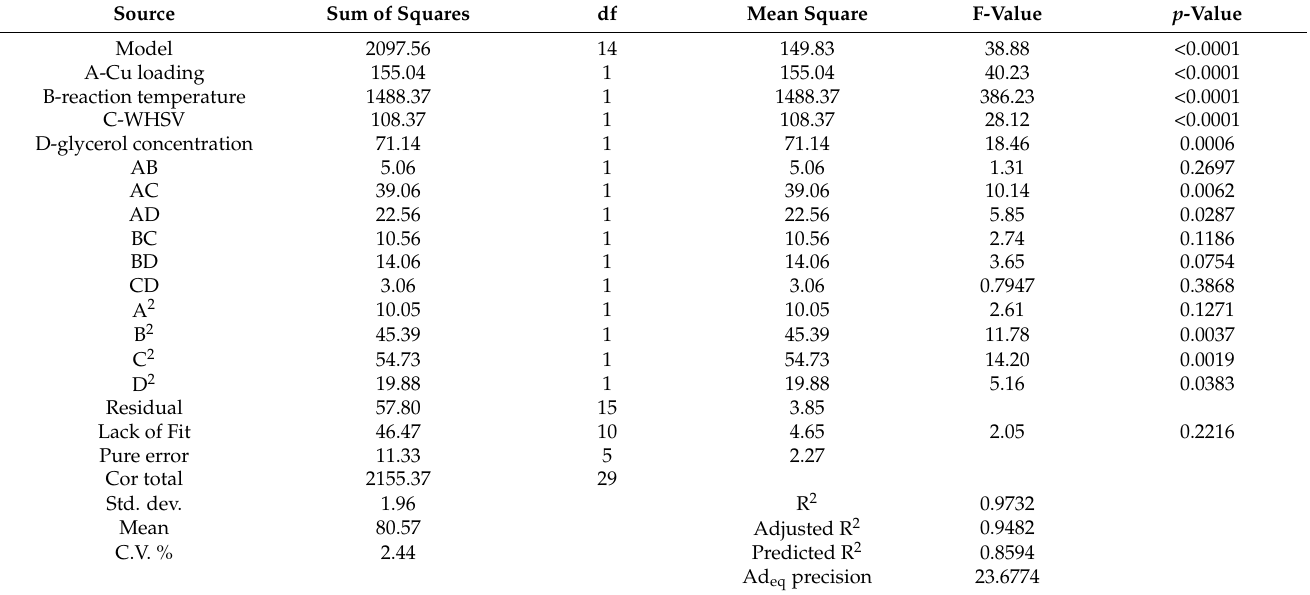
Table 3. Analysis of variance (ANOVA) for response surface of quadratic model for Equation (14).